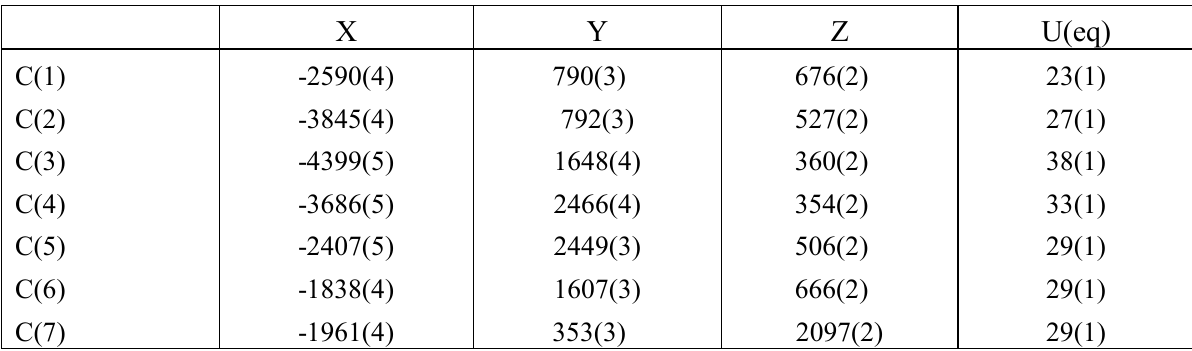
Table 3. Atomic coordinates (x 10 4 ) and equivalent isotropic displacement